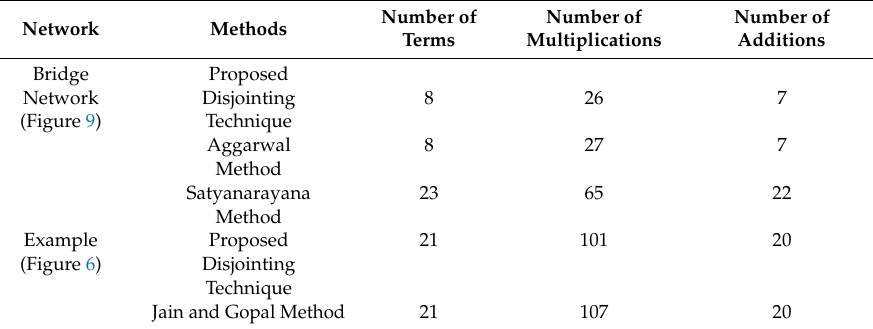
Table 3. Comparison of di ff erent methods.